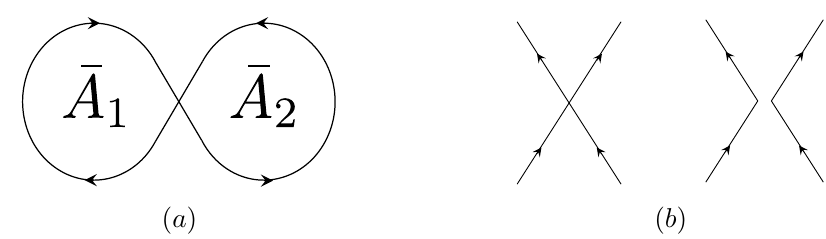
Figure 1 . ( a ) The (cid:12)gure eight Wilson loop with areas (cid:22) A 1 and (cid:22) A 2 . ( b ) Two intersecting lines (left) and two touching lines (right) which mix under the renormalization group